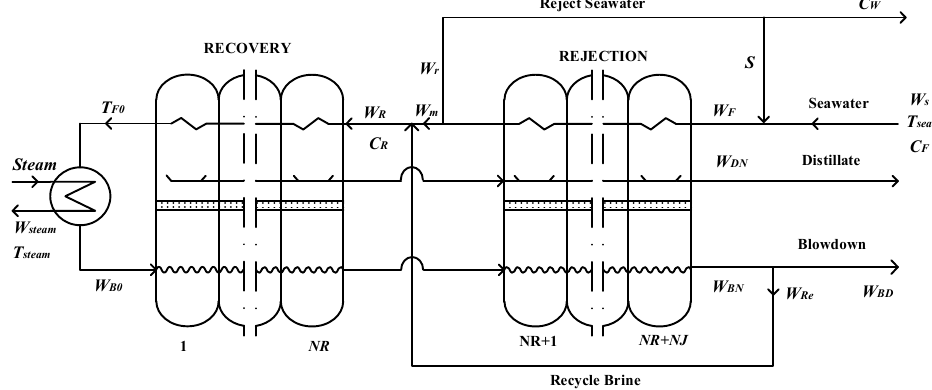
Figure 1. Multi-stage flash (MSF) desalination system.